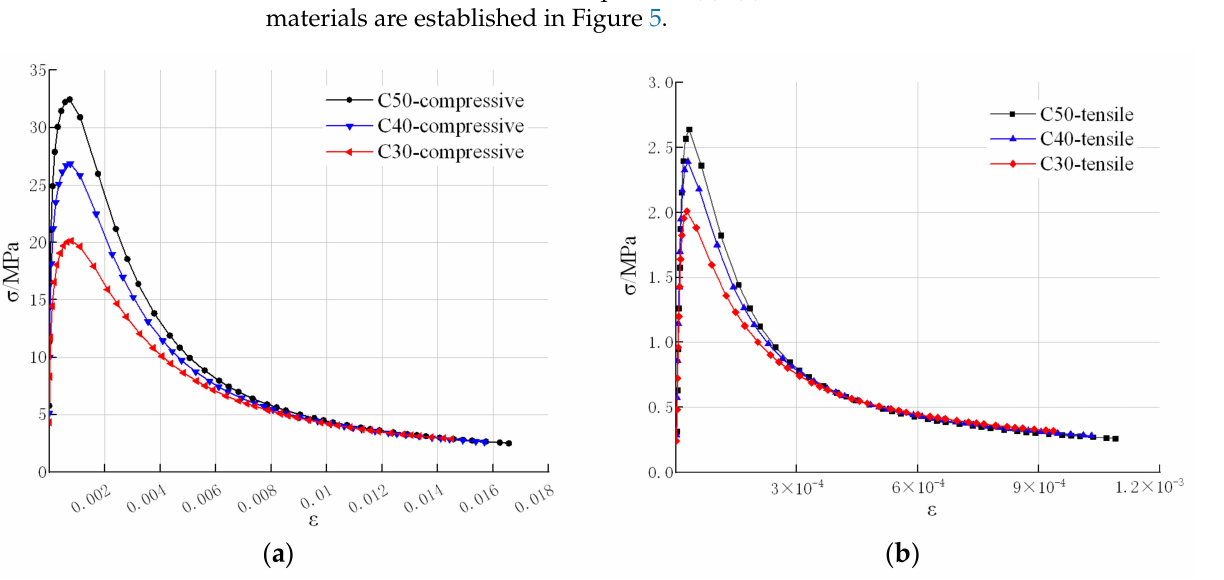
Figure 5. Stress-strain curves for ( a ) compressive and ( b ) tensile behaviors of C30–C50 concrete